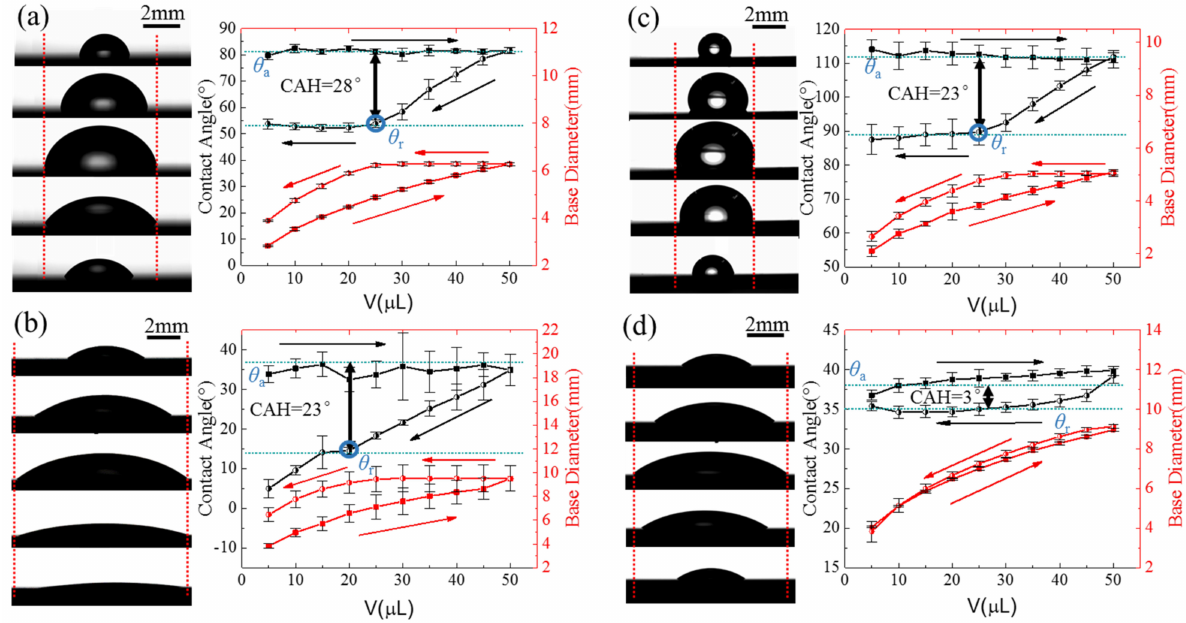
Figure 3. The variation in the base diameter (BD) and contact angle (CA) of a water droplet on the test surface as a function of the droplet volume. Advancing contact angle, receding contact angle, and contact angle hysteresis of a water droplet on the ( a ) plain hydrophilic surface, ( b ) hydroxylated hydrophilic surface, ( c ) plain hydrophobic surface, and ( d ) ultra-slippery hydrophilic